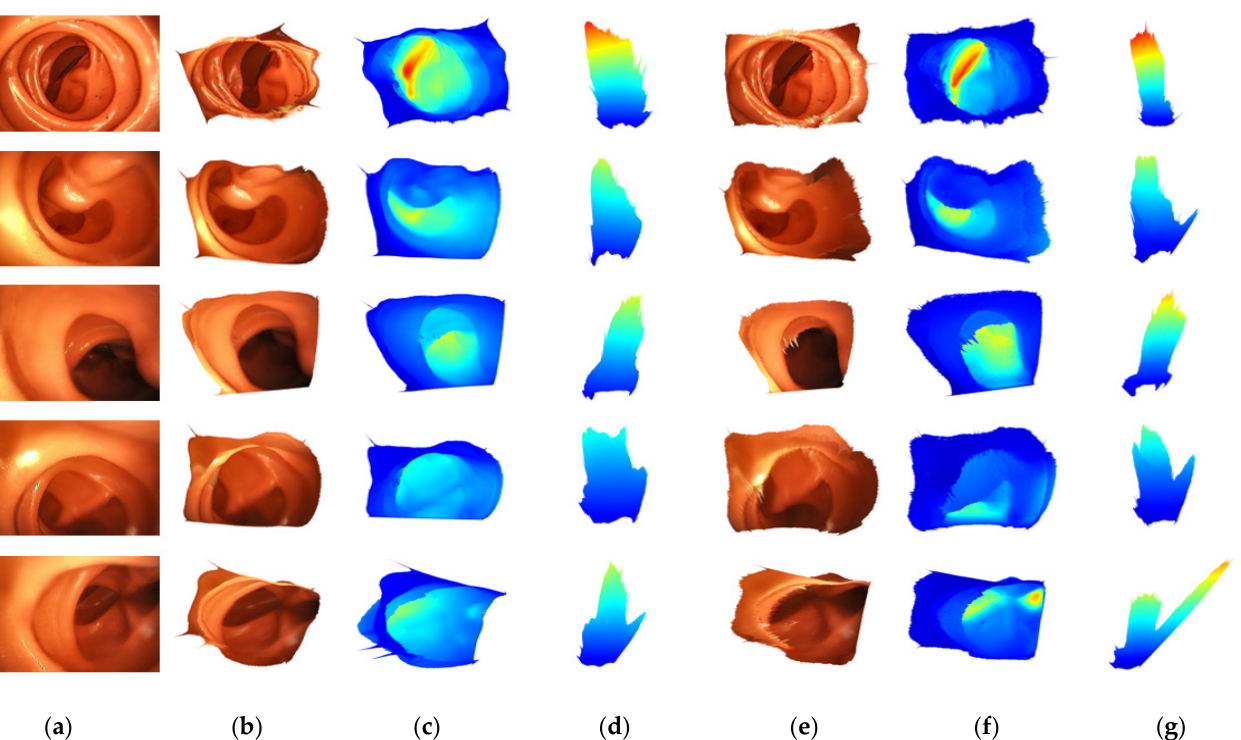
Figure 8. Qualitative results for 3D reconstruction. ( a ) is an input image taken with the camera in colonoscopy simulation. ( b – d ) are results of FBNet. ( e – g ) are results of Packnet-SfM. ( b , e ) are the results of 3D reconstruction image mapping. ( c , f ) are expressed as colormaps according to the depths of ( b , e ). ( d , g ) are the top-view of ( c , f ).